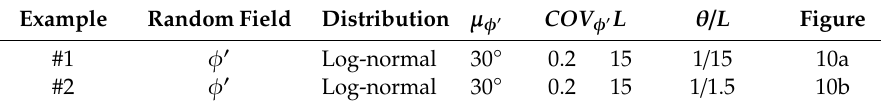
Table 2. Summary of the values of parameters defining the two examples.